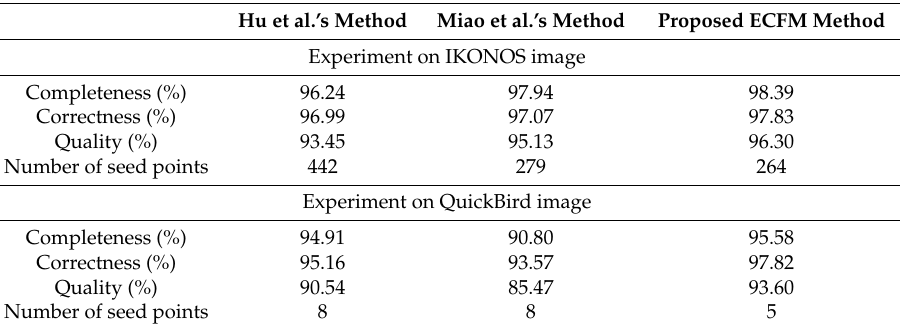
Figure 6. Comparison of the results provided by different road extraction methods for an IKONOS image. ( a ) Case 1; ( b ) Case 2; ( c ) Case 3; ( d ) Case 4. Table 2. Quantitative Evaluation of Different Centerline Extraction